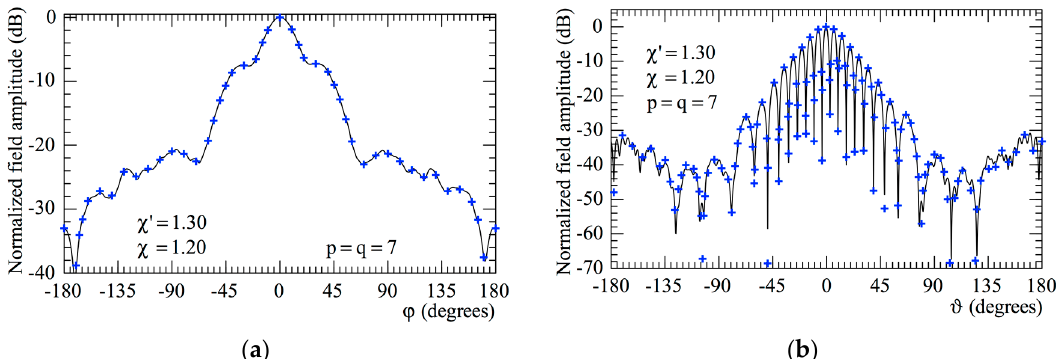
Figure 10. Far-field pattern. ――― reference obtained when mounting the AUT in a non-centered configuration. + + + + interpolated from the non-redundant samples: ( a ) E-plane; ( b ) H-plane.